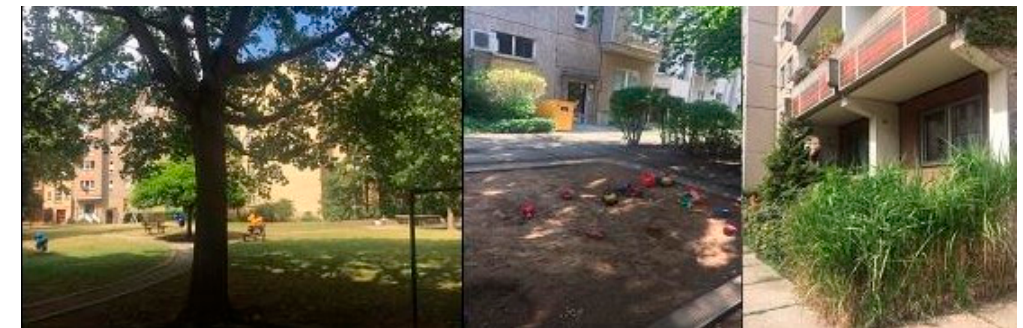
Figure 4. Greening the backyards and courtyards in socialist pre-fabricated housing estates of Leipzig Center as an essential element of socialist housing development and urban planning strategy. Photos: D. Dushkova.